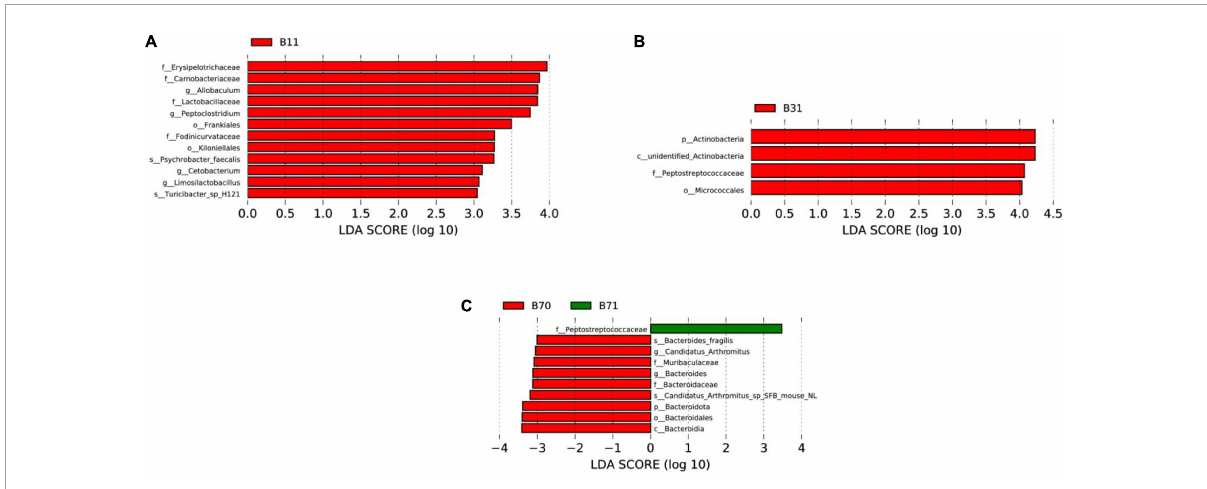
FIGURE5 LEfSe comparison between the good and poor communication score groups. (A) LDA score histogram of differential microbiota of the two groups on day 1. (B) LDA score histogram of differential microbiota of the two groups on day 3. (C) LDA score histogram of differential microbiota of the two groups on day 7. p_ represents phylum level, c_ represents class level, o_ represents order level, f_ represents family level, g_ represents genus level, and s_ represents species level. B11, gut microbiota of the poor communication score group on day 1; B31, gut microbiota of the poor communication score group on day 3; B71, gut microbiota of the poor communication score group on day 7; B70, gut microbiota of the good communication score group on day